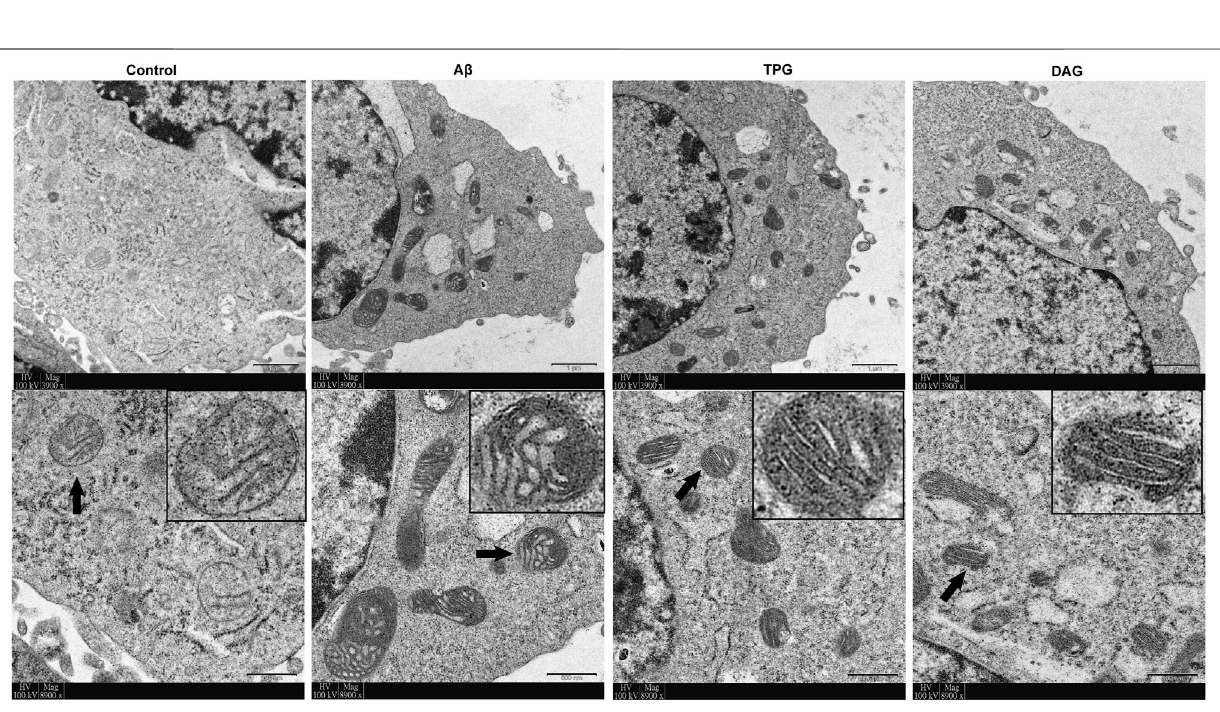
FIGURE 2 | The improvement of TPG and DAG on mitochondrial ultrastructure in the A β 25 – 35 -exposed cells. The transmission electron microscope (TEM) was used to examine ultrathin slices or in different groups. The images below each group were the enlarged representative mitochondria. The representative mitochondria markedbyblackarrowineachgroupweremagni fi edintheblackbox.Magni fi cation: × 3,900and × 8,900,respectively.Scalebars:1 μ mand500 nm,respectively.TPG, tortoise plastron gelatin; DAG, deer antler